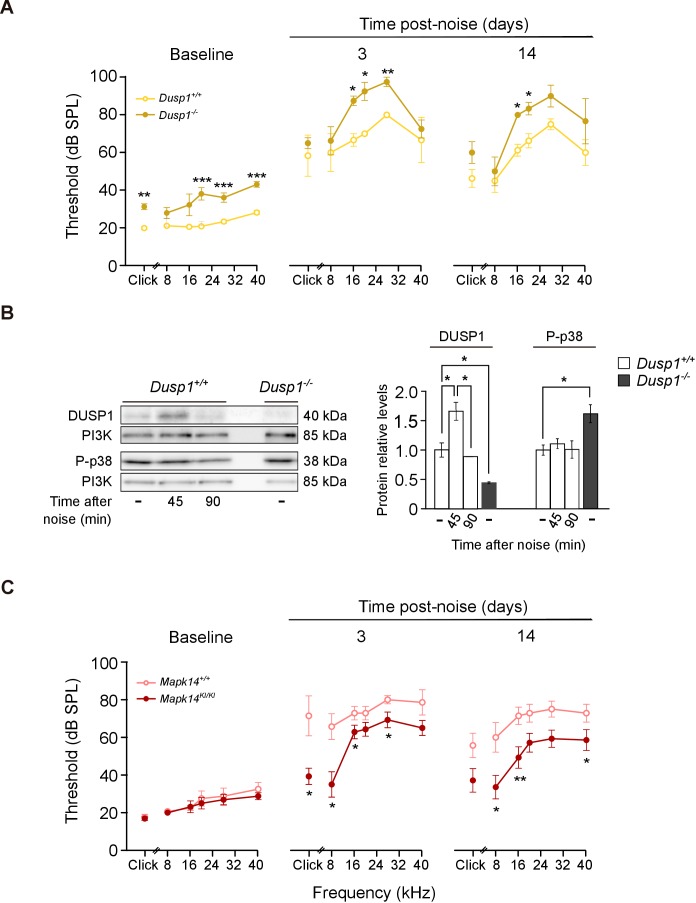
Hearing loss following noise-exposure of Dusp1 and Mkp14 null mice.(A) ABR thresholds (mean ± SEM) in response to click and tone burst stimuli before noise exposure (baseline) and 3 and 14 days post-noise (VSS, 107 dB, 30 min) exposure in Dusp1+/+ and Dusp1–/– mice (n = 4 per genotype). (B) Representative blots and quantification of levels are shown for DUSP1 and P-p38 cochlear protein extracts from Dusp1+/+ and Dusp1–/– mice and wildtype mice, 45 and 90 min after noise exposure. Expression levels were calculated as a ratio using PI3K as the loading control. Values are presented as mean ± SEM of triplicates from pool samples of three mice per condition. (C) Evolution of ABR thresholds (mean ± SEM) in response to click and tone burst stimuli before (baseline) and 3 and 14 days post-noise exposure in Mkp14+/+ and Mpk14KI/KI mice (n = 7 per genotype). Statistically significant differences were analyzed by Kruskal–Wallis tests comparing genotypes (*p<0.05, **p<0.01, ***p<0.001).